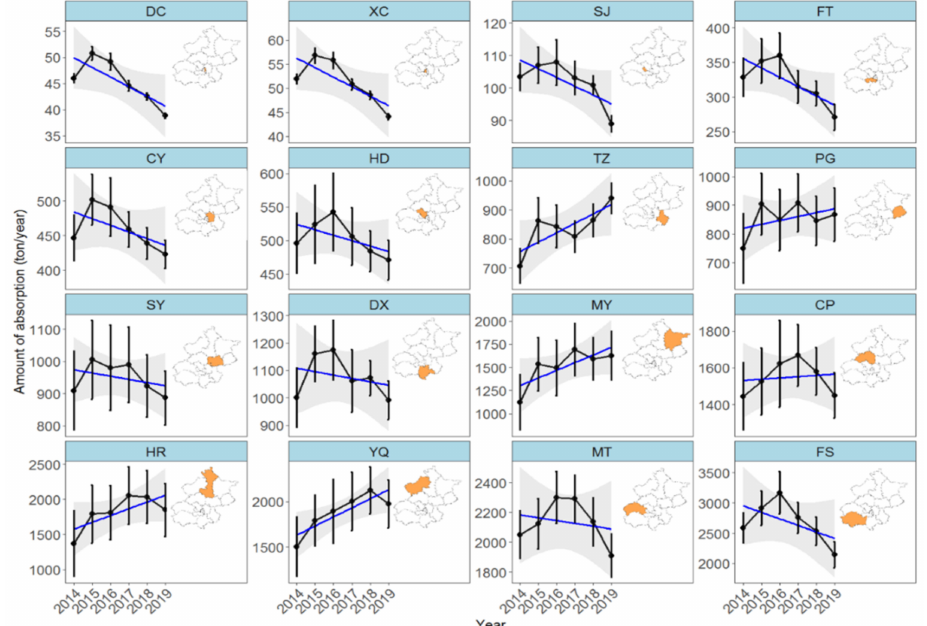
Figure 2. Trend of NO 2 absorption by urban forests in 16 districts of Beijing from 2014 to 2019. Mean absorption values are represented by points, max/min absorption is represented by error bars. The regression line was calculated based on the mean values. The 95% confidence interval of fitted mean value is represented by the shaded